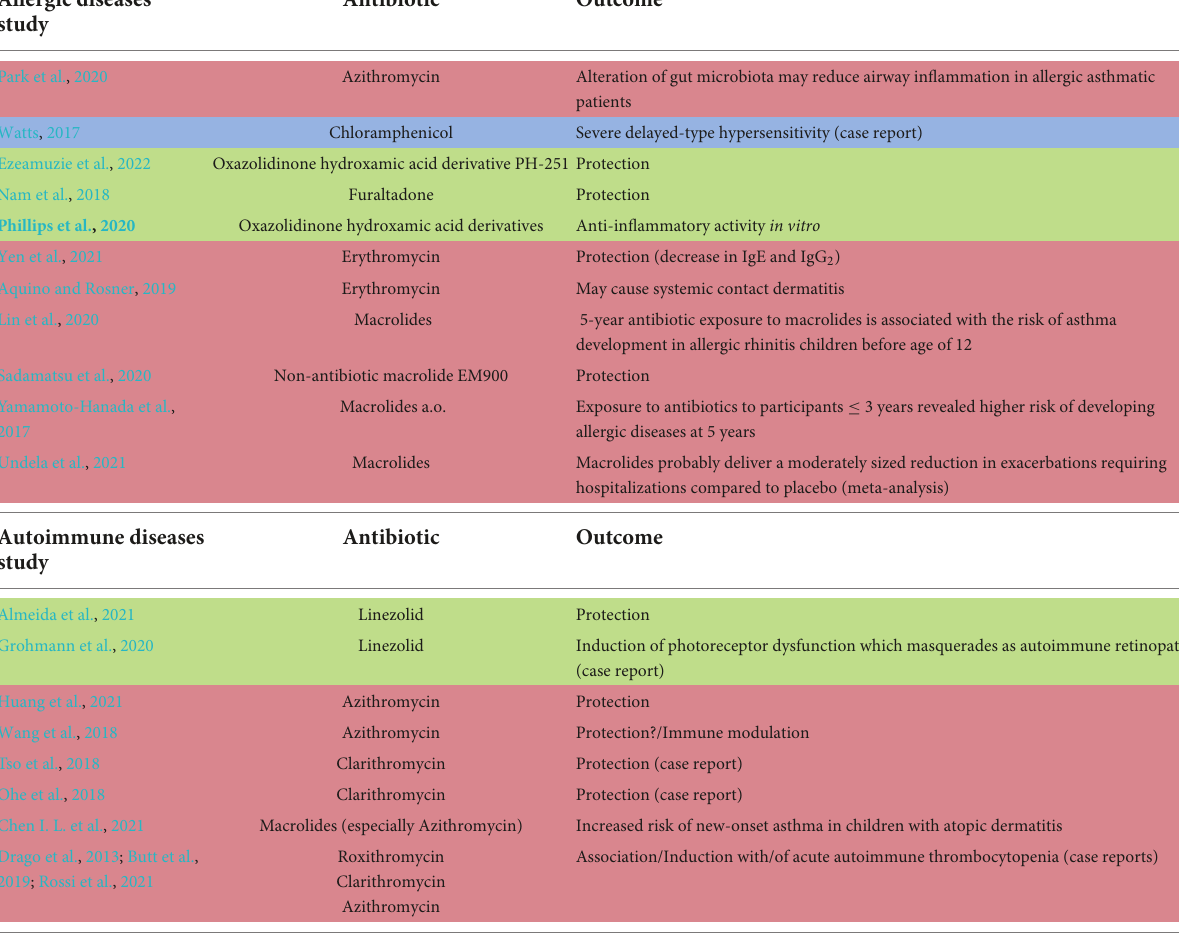
TABLE 1 Studies investigating the effect of macrolides (red), phenicols (blue) and oxazolidinones (green) on allergic and autoimmune